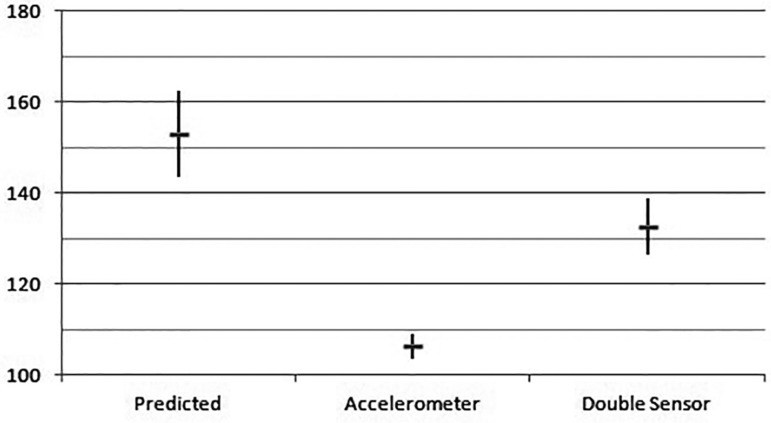
Maximal Heart Rate and standard deviation (in bpm) obtained in the ergoespirometry
test.